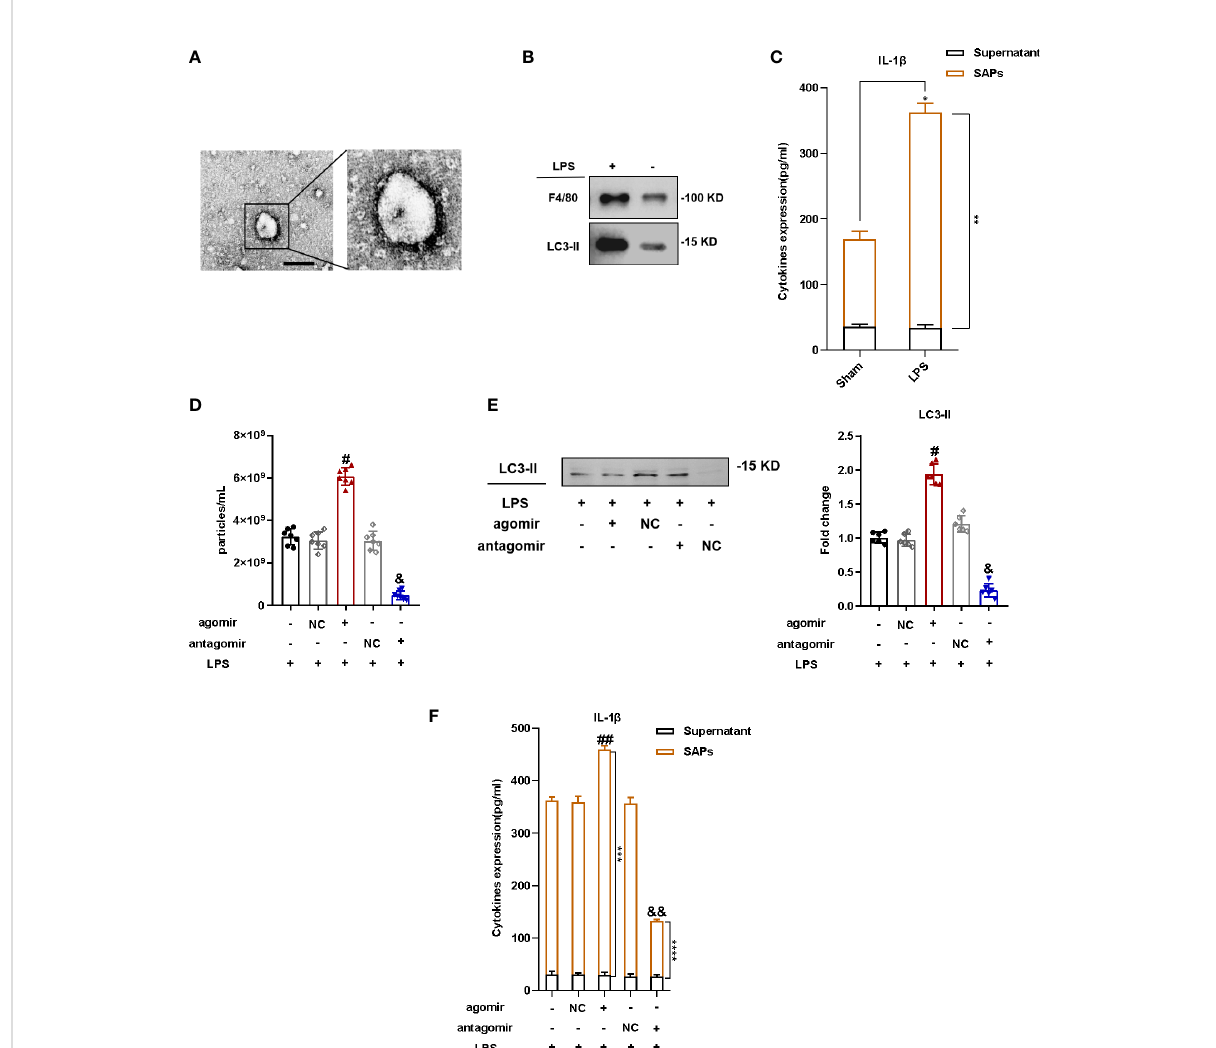
FIGURE 3 MiR-199a-3p over-expression increased SAP secretion in ARDS mice. SAPs were isolated from the BALF of mice via centrifugation. (A) The vesicles from BALF were identi fi ed via transmission electron microscopy (scale bar 200 nm). (B) Western blotting analysis revealed that the vesicles from BALF expressed LC3-II and F4/80. (C) The levels of IL-1 b in SAPs and BALF supernatant were assessed via ELISA after the SAPs were lysed using Triton X-100 (n = 6 per group). (D) Nanoparticle tracking analysis revealed signi fi cant increases in the levels of vesicles in the BALF of mice injected with the agomir of MiR-199a-3p, compared with the control group (n = 7 per group). (E) Western blot analysis demonstrated signi fi cant increases in the levels of LC3-II in vesicles from the BALF of mice injected with the agomir of MiR-199a-3p, compared with the control group (n = 7 per group). (F) The levels of IL-1 b in SAPs and the BALF supernatant were assessed via ELISA after the SAPs were lysed using Triton X-100 (n = 6 per group). The experiments were repeated at least three times. Each value represents the mean ± SD of three independent experiments. *p < 0.05 vs . the SAPs + supernatant in the sham group; **p < 0.05 vs . the SAPs in the sham group; #p < 0.05 vs . agomir NC group; & p <0.05 vs . antagomir NC group; ##p< 0.05 vs . the SAPs + supernatant in the agomir NC group; ***p < 0.05 vs . the SAPs in the agomir NC group; && p < 0.05 vs . the SAPs + supernatant in the antagomir NC group; ****p < 0.05 vs . the SAPs in the antagomir NC group, Student ’ s t -test or one-way